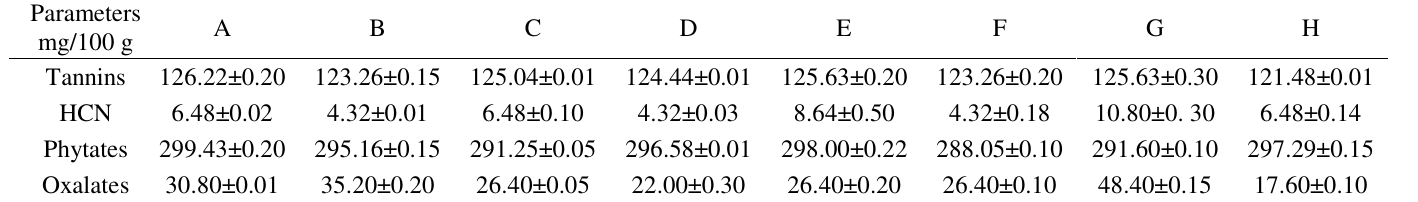
Table 1. Anti-nutrients composition of some bread and flour samples in Uyo